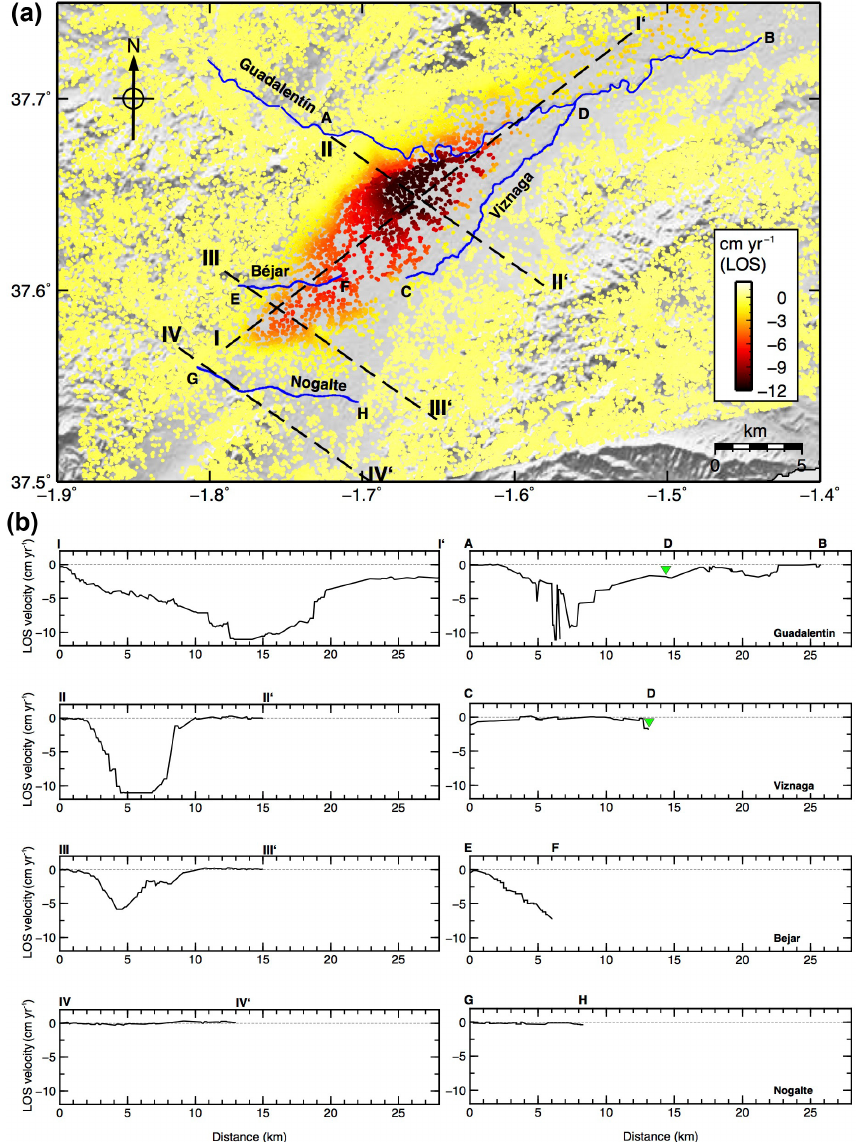
Figure 9. (a) Ground deformation measured by InSAR: coloured dots represent InSAR velocities for the period 2003–2010 in the satellite’s line of sight (LOS, ∼ 23 ◦ from the vertical). The four channels analysed in this work are represented by black lines. (b) Cross sections: ground deformation velocities measured along the four discontinuous white lines in A (profiles with flags I–IV) and along the four channels identified in the map (profiles with flags